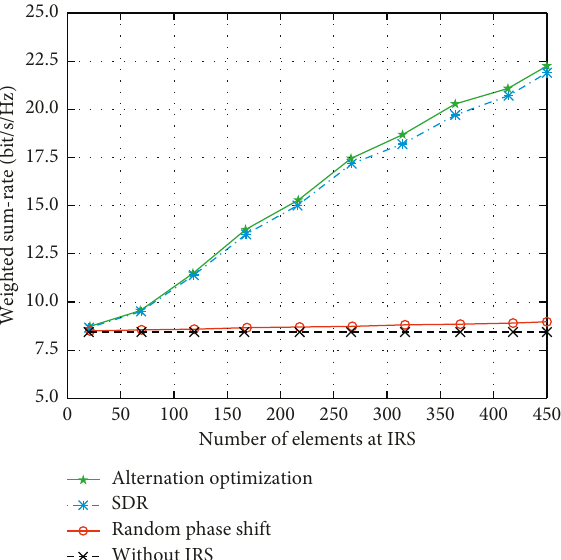
Figure 9: Change curve of the achievable rate with the number of reflecting